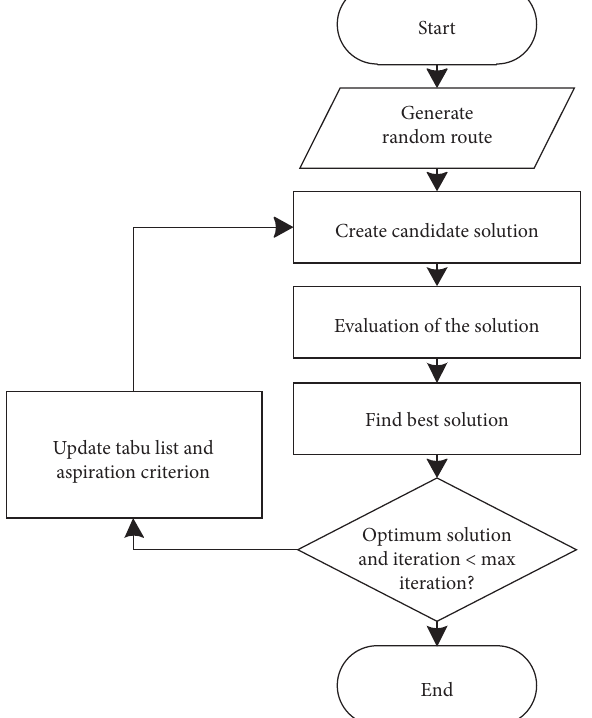
Figure 5: Flowchart of the tabu search algorithm.